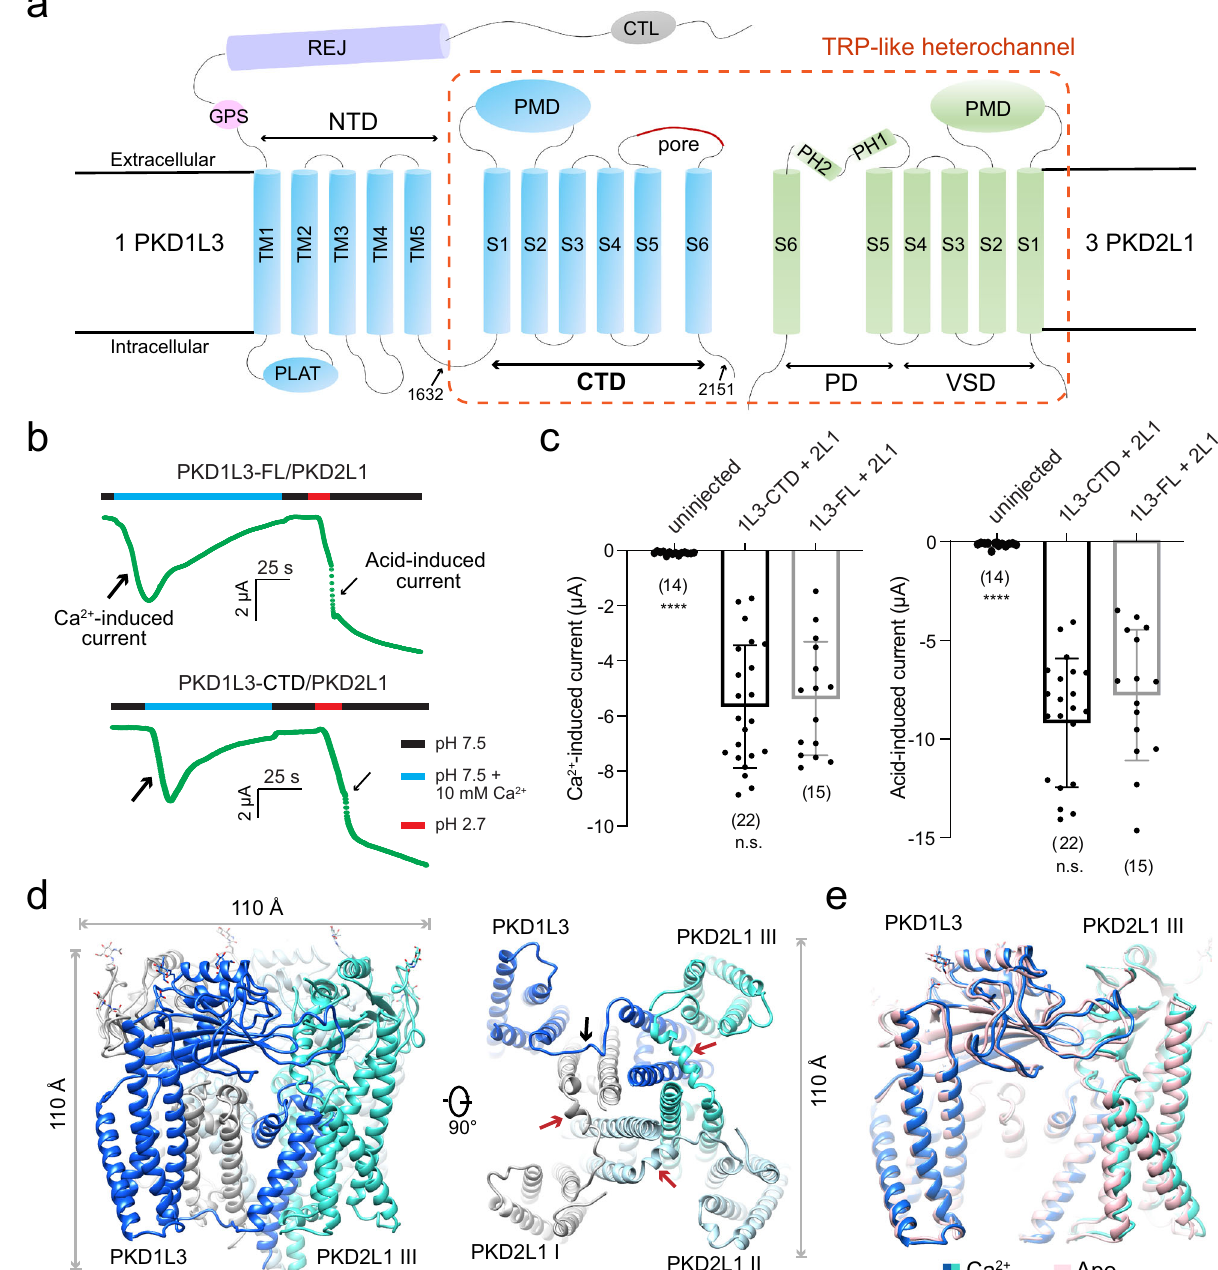
Fig. 1 The PKD1L3-CTD/PKD2L1 heterocomplex retains Ca 2 + and acid-induced channel activity. a Topology diagram of PKD1L3 and PKD2L1. PKD1L3, and PKD2L1 proteins assemble to a heterocomplex with a stoichiometric ratio of 1:3. The constructs used for structural determination in this study, mouse PKD1L3-CTD (residues 1632 – 2151) and PKD2L1 (residues 64 – 629), are indicated by the dashed box. CTL C-type lectin domain, REJ sperm receptor for egg jelly, PLAT Polycystin-1, Lipoxygenase, α -toxin domain, PMD polycystin-mucolipin domain, PD pore domain, VSD voltage-sensing domain. b The Ca 2 + and acid-induced channel activity of the PKD1L3-CTD/PKD2L1 heterocomplex is similar to that of the full-length (FL) channel. The Ca 2 + and acid-induced currents were recorded from Xenopus oocytes expressing either full-length PKD1L3 or PKD1L3-CTD with PKD2L1. Shown here are representative traces for gap-free recording at − 80 mV. c Scatter plots and bar graphs of the Ca 2 + -induced currents at − 80 mV recorded from oocytes expressing the indicated proteins. The number of oocytes is shown below each bar. Data are presented as mean ± SD in the bar graph. Currents in each group are compared with that of PKD1L3-FL/2L1-injected group with two-sided Student ’ s t test. n.s.: not signi fi cant; **** P < 0.0001. d The side (left) and intracellular (right) views of the cryo-EM structure of the PKD1L3-CTD/PKD2L1 complex. For simplicity, we will call it PKD1L3/2L1. The glycosyl moieties are shown as sticks. The black and red arrows highlight the different structures of the S4 – S5 linkers in PKD1L3 and the three PKD2L1 subunits, respectively. e Structural comparison of PKD1L3/2L1 with and without added Ca 2 + . The two structures will be referred to as “ Ca 2 + -loaded ” and “ apo ” . All structural fi gures were prepared in UCSF chimera 65 if not otherwise